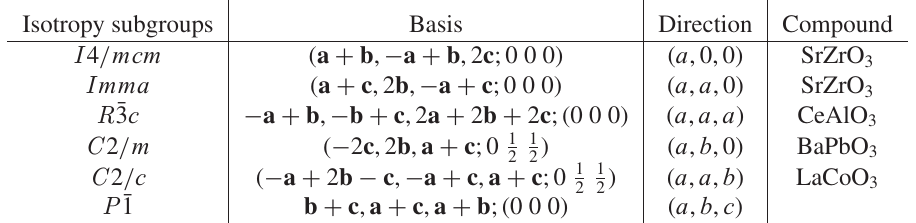
Table 4. Isotropy subgroups of P m ¯3 m for irrep R + . In this table, the triad in the third column indicates for each 4 space group the restricted direction (one of a set of equivalent ones) of the order parameter in its 3-dim space, in the representation basis used in [11].